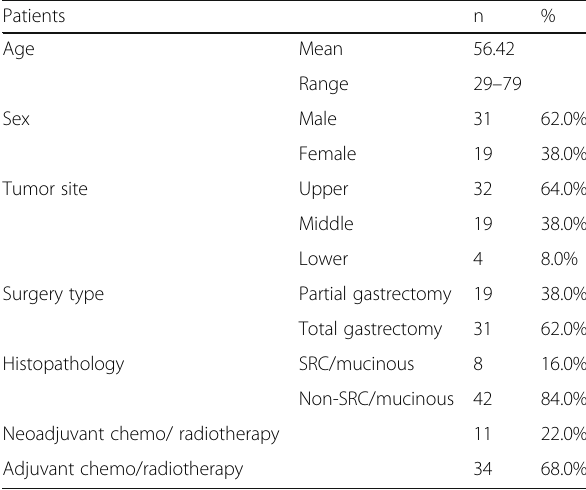
Table 1 Patients ’ demographic data Patients